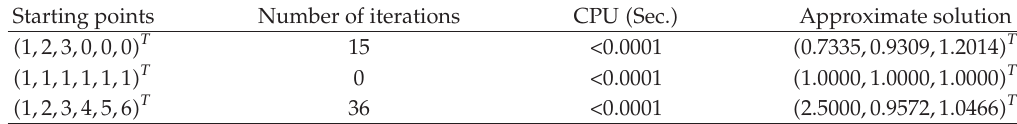
Table 2: Results for Example 6.1 using FB type HRP method.